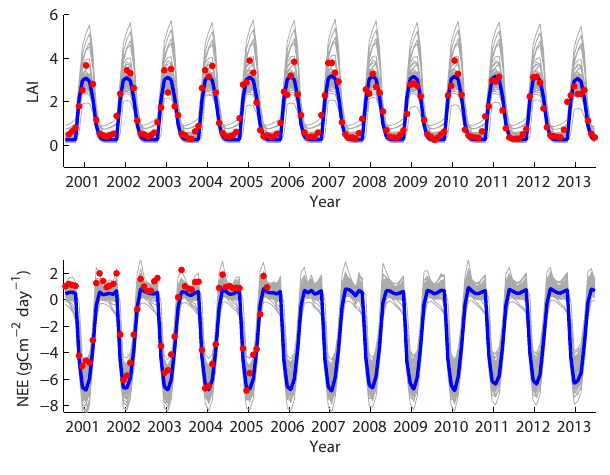
Figure 10. DALECv2 monthly estimates for LAI and NEE at Mor- gan Monroe State Forest. The red dots are the observations, the blue trajectories are obtained using the 4DVAR analysis, and the grey tra- jectories are ensemble runs obtained from a 95% confidence sample of the posterior PDF.